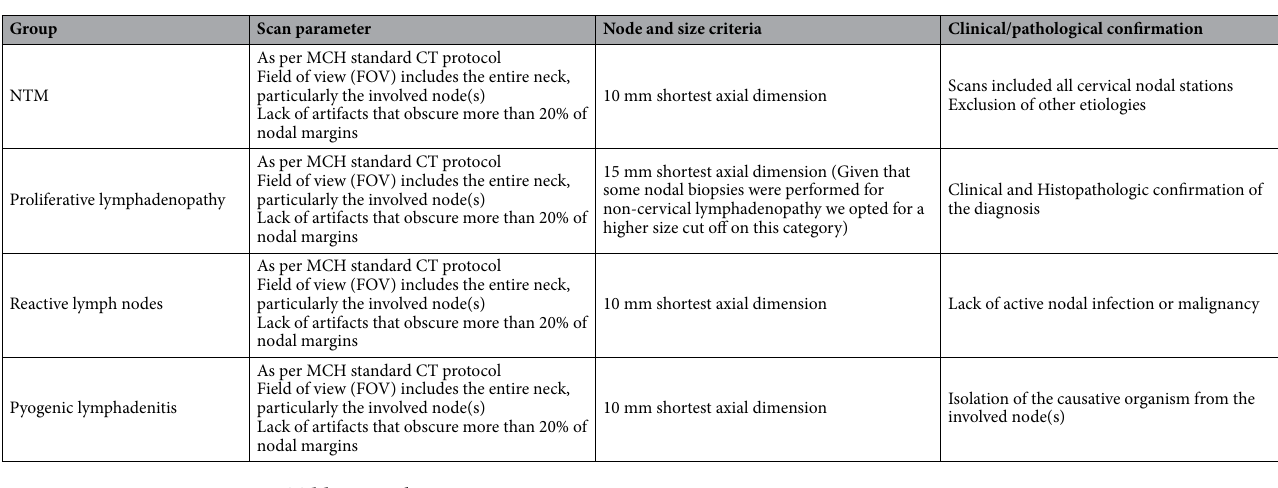
Table 5. Inclusion